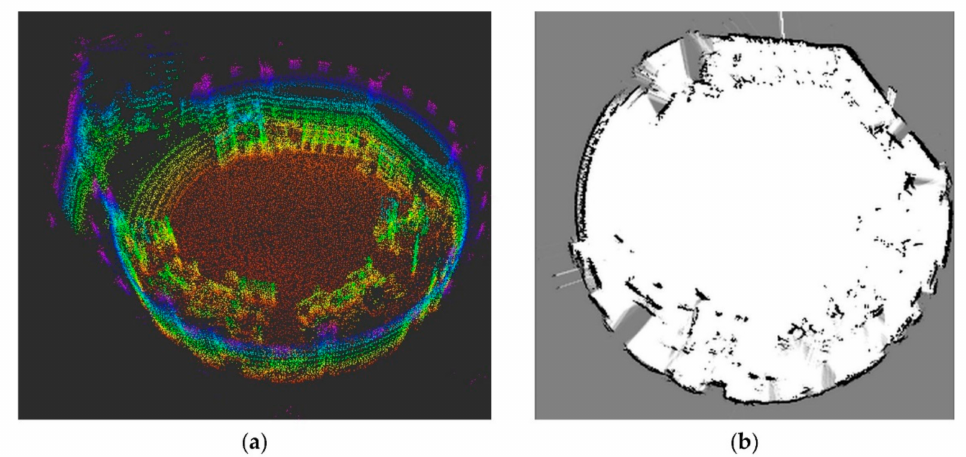
Figure 18. A priori maps used for localization experiments. ( a ) 3D point cloud map without roof; ( b ) 2D occupancy grid